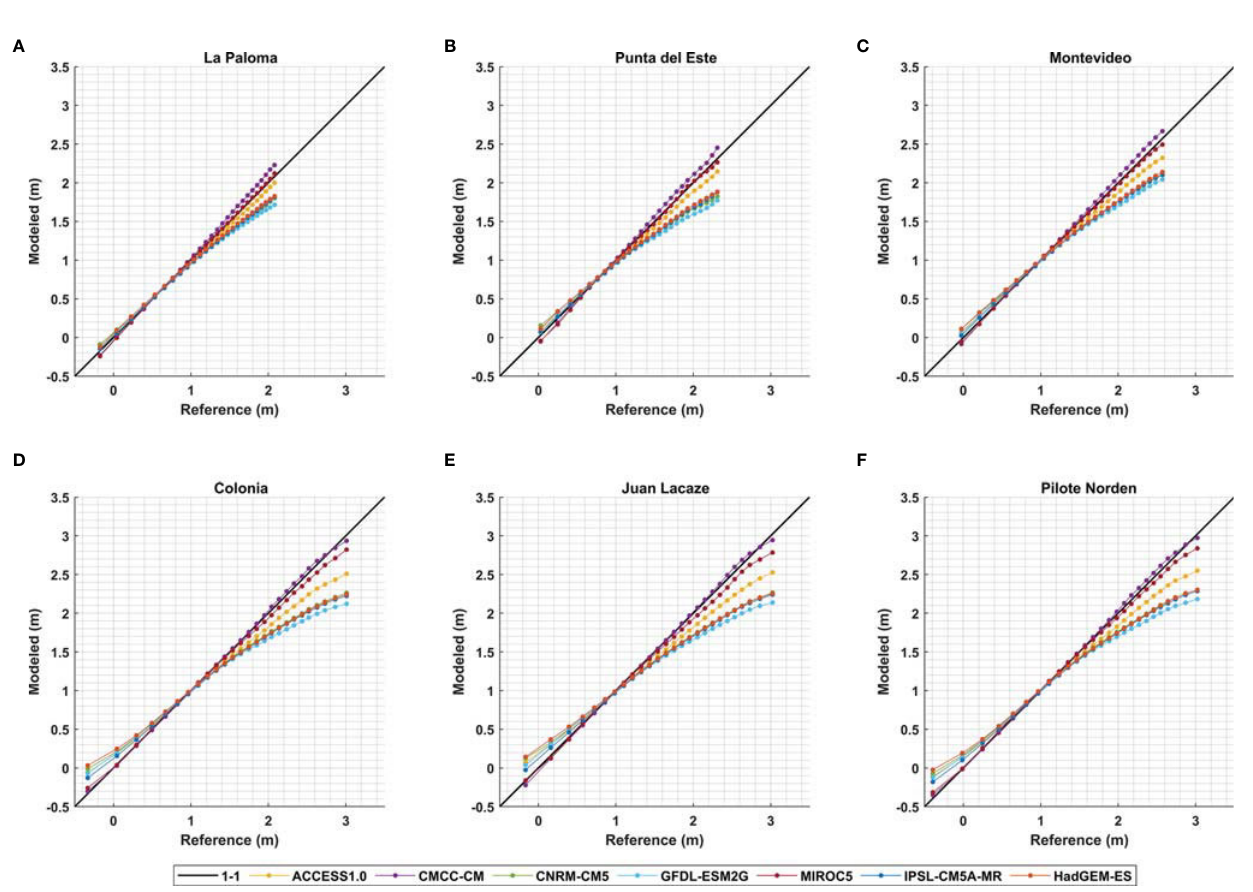
FIGURE 7 | QQ-plots of data obtained from the local model forced with each GCM (Modeled) vs reference data (Reference) for the historical period (1986-2005): (A) La Paloma, (B) Punta del Este, (C) Montevideo, (D) Juan Lacaze, (E) Colonia and (F) Pilote Norden. 25 equispaced quantiles shown with Gumbel scale ranging from 0.001 to